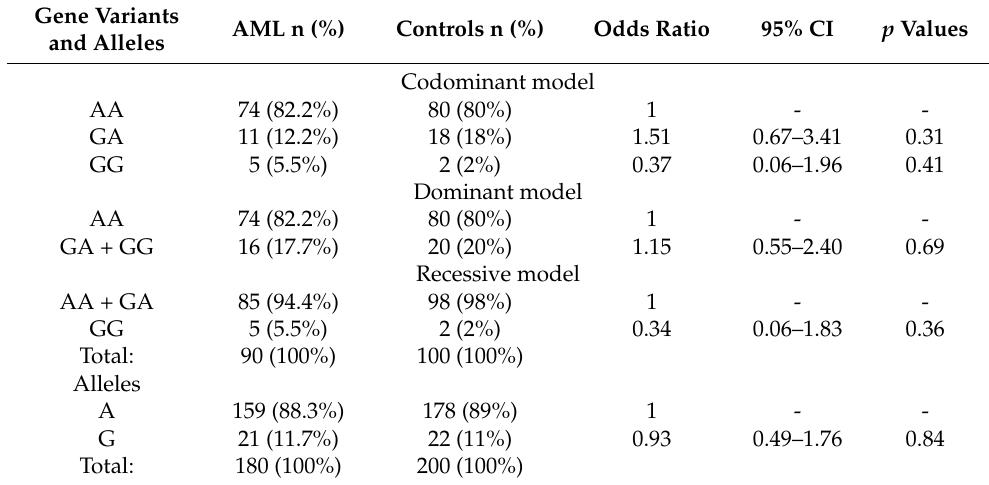
Table 3. The comparison of allele frequency and distribution of WT1 variant among AML patients and controls.